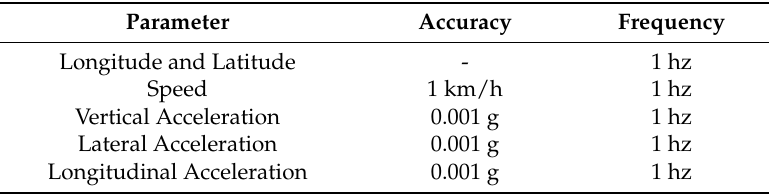
Table 2. Data Collected by Inner Sensor of Driving Recorder.